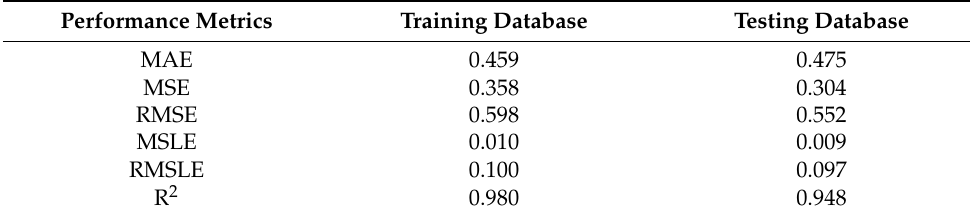
Table 8. Results of GP to predict CBR for mixtures of alum sludge and